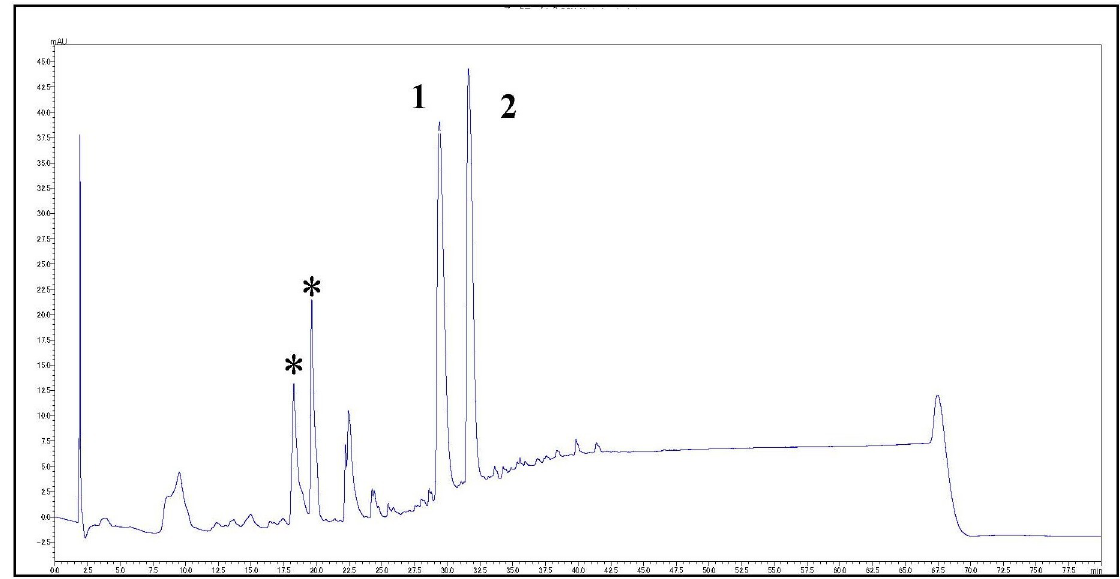
Fig 1. HPLC chromatogram of a crude extract of the actinomycete RA2 (peaks with asterisk were obtained from media).